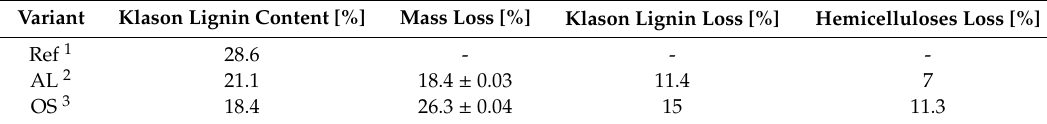
Table 1. Comparison of Klason lignin content and mass loss of native and chemically treated spruce veneers based on the assumption that no cellulose degradation occurs. (Klason lignin content: n = 2 for Ref; n = 2 for AL; n = 1 for OS. Mass loss: n = 4 for AL; n = 6 for OS).